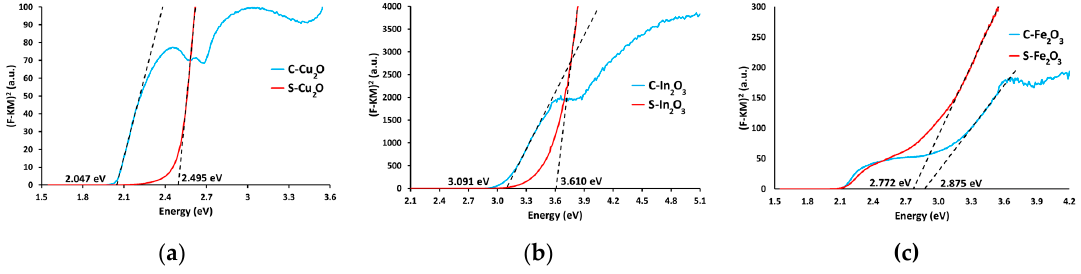
Figure 6. Tauc Plots for ( a ) Cu 2 O, ( b ) In 2 O 3 , and ( c ) Fe 2 O 3 binary oxide